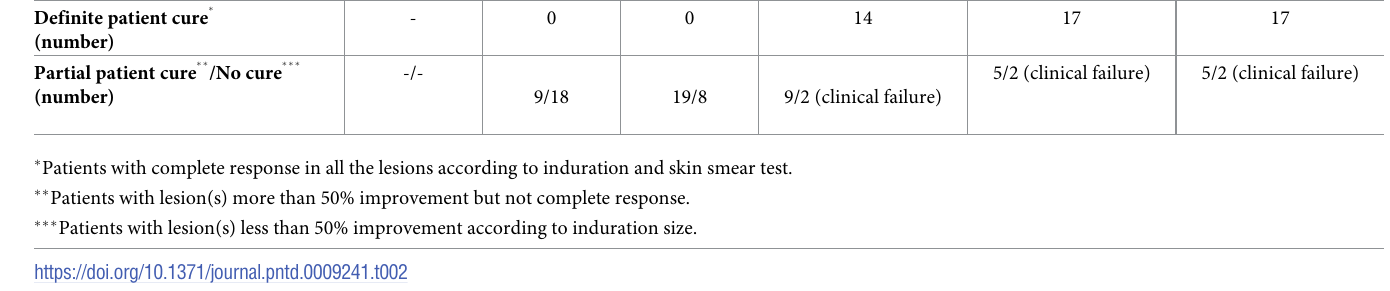
Table 2. Efficacy of oral miltefosine on 27 patients with acute anthroponotic cutaneous leishmaniasis. Variable Base line Treatment Follow up 14 days 28 days 3 month 6 month 12 month Lesion size (Cm) 2.38 ± 0.73 1.31 ± 0.59 0.61 ± 0.23 0.26 ± 0.12 0.21 ± 0.08 0.03 ± 0.01 Definite patient cure � - 0 0 14 17 -/- 5/2 (clinical failure) 9/18 19/8 � Patients with complete response in all the lesions according to induration and skin smear test. �� Patients with lesion(s) more than 50% improvement but not complete response. ��� Patients with lesion(s) less than 50% improvement according to induration